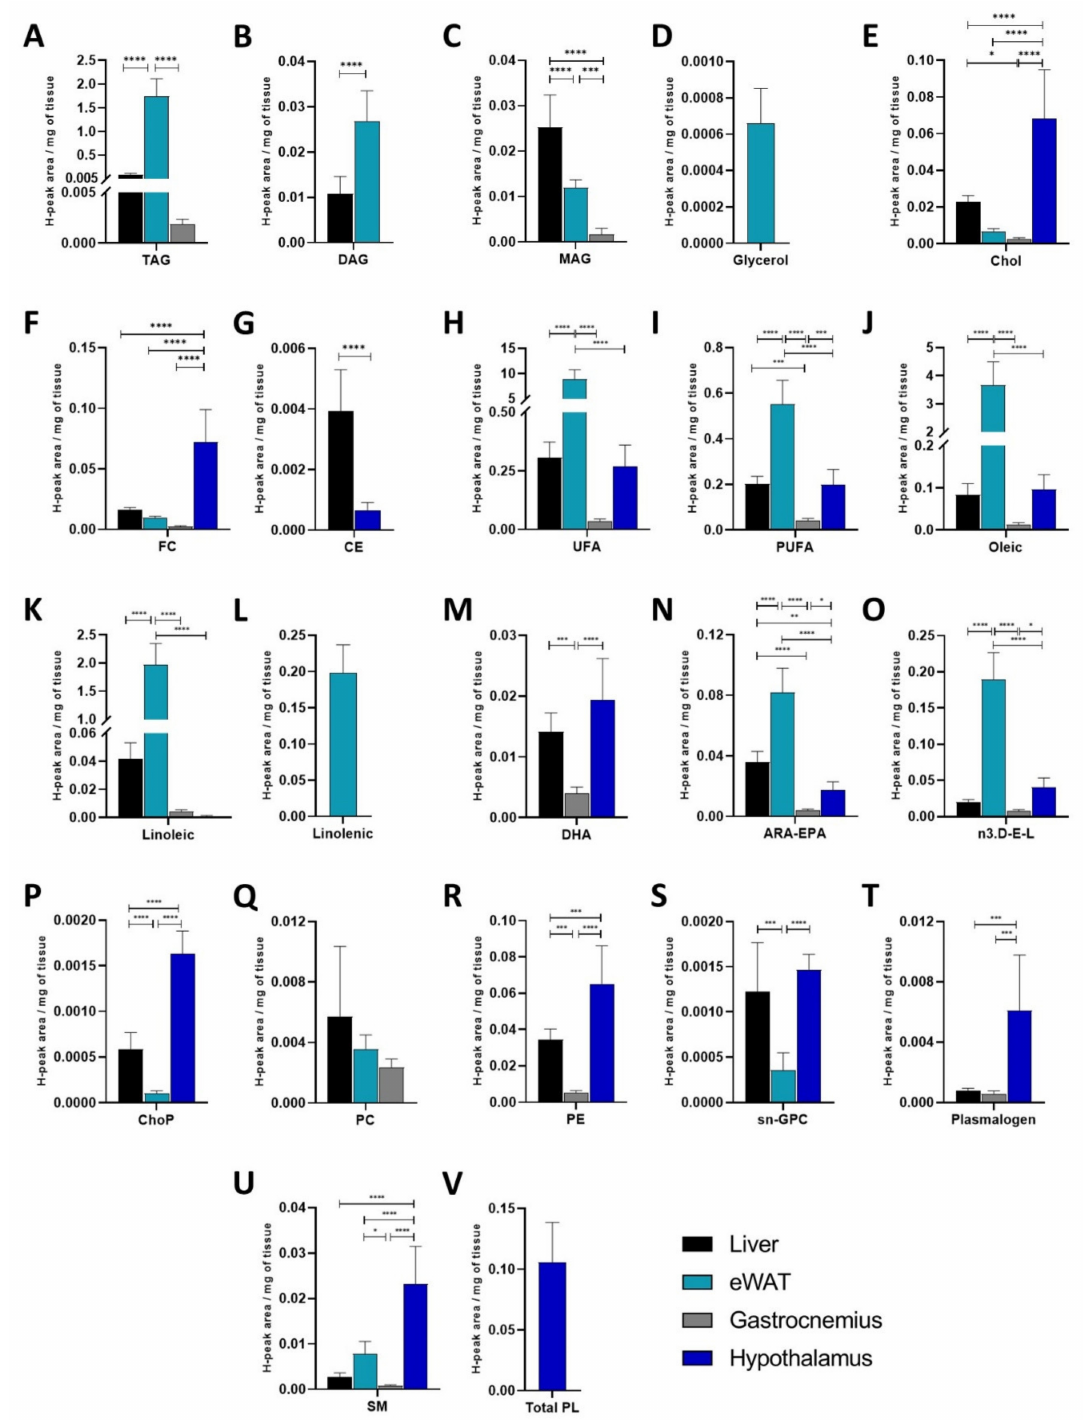
Figure 2. Lipid profiles of liver, eWAT, gastrocnemius and hypothalamus. Comparison of the presence of glycerolipids ( A – D ), sterol lipids ( E – G ), fatty acids ( H – O ), phospholipids and sphingolipids ( P – V ) in 4 different tissues from control mice. Liver n = 8, eWAT n = 8, gastrocnemius n = 8, hypothalamus n = 7. Y-axis values indicate proton-based NMR peak area normalised to sample weight (H-peak area/mg of tissue). Data represented as mean ± SEM, one-way ANOVA and post-hoc Tukey’s tests, * p < 0.05, ** p < 0.01, *** p < 0.001, and **** p <